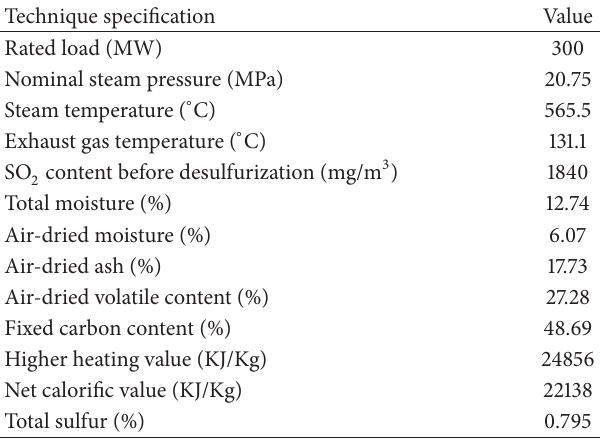
Table3:Techniquespecificationoftheboilerandindustrialanalysis data of coal of experiment II.